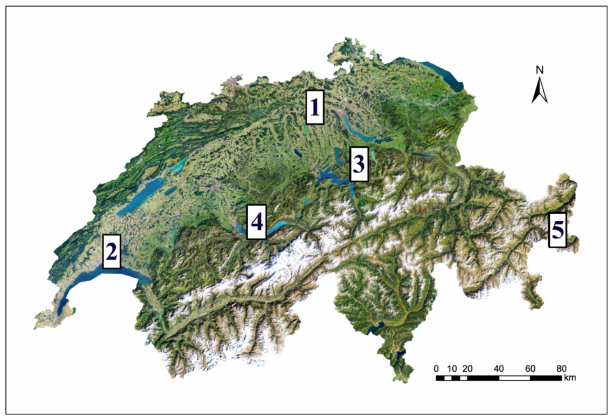
Figure 1. Sample locations, all of which are part of the Long-term ecosystem research program (LWF) of the Swiss Federal Institute for Forest, Snow and Landscape Research, WSL: (1) Othmarsin- gen, (2) Lausanne, (3) Alptal, (4) Beatenberg, and (5) Nationalpark. Image made using 2016 swisstopo